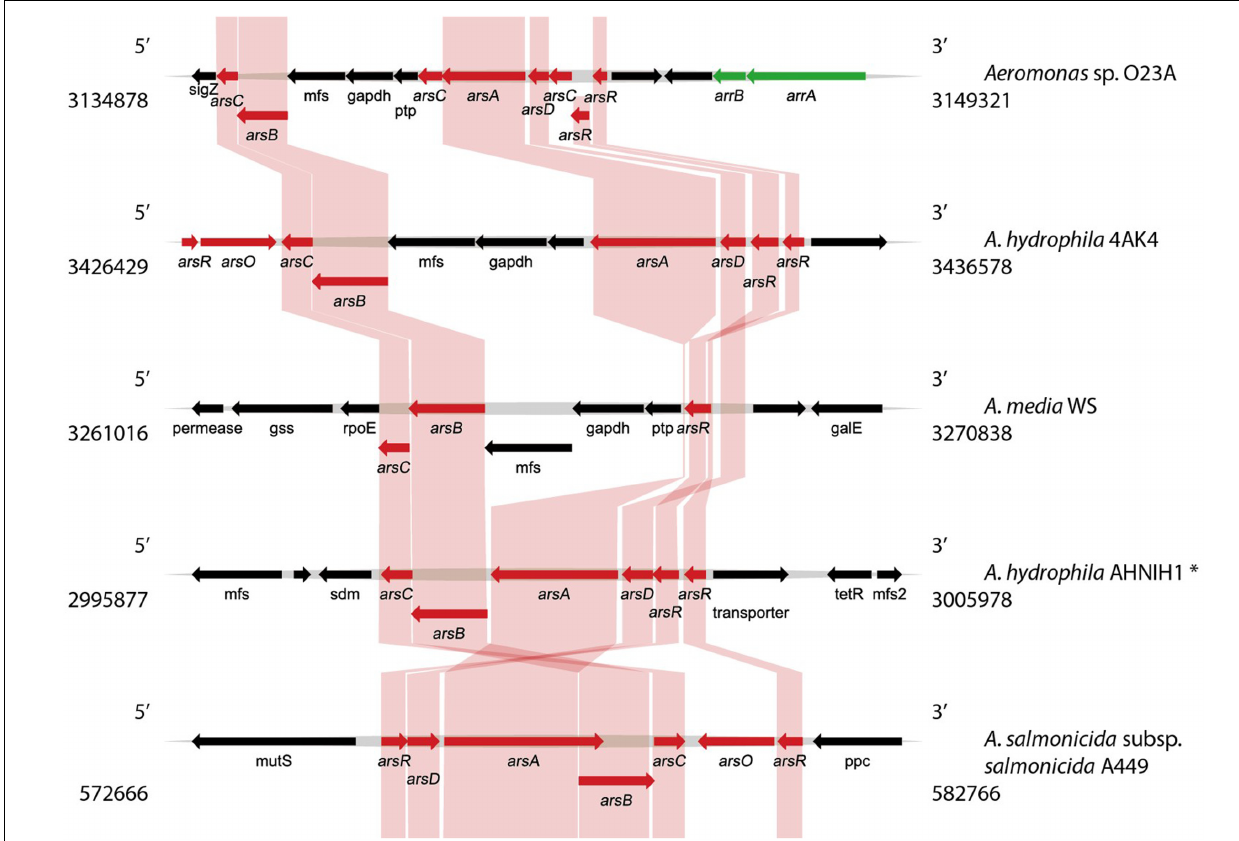
FIGURE 3 | Comparative analysis of the arsenic resistance and respiration genes (Module 1) found within the O23A chromosome, with the most similar modules found in genomic databases. Genes encoding proteins involved in arsenic resistance ( ars ) are indicated in red, whereas genes responsible for arsenic respiration ability ( arr ) are green. Homologies are indicated by colored frames. Location of the genome fragments used for the analysis are provided for each analyzed sequence. ∗ A. hydrophila AHNIN1 module was used as a representative of several other A. hydrophila strains, whose genomic structure of the ars module was highly similar to that of